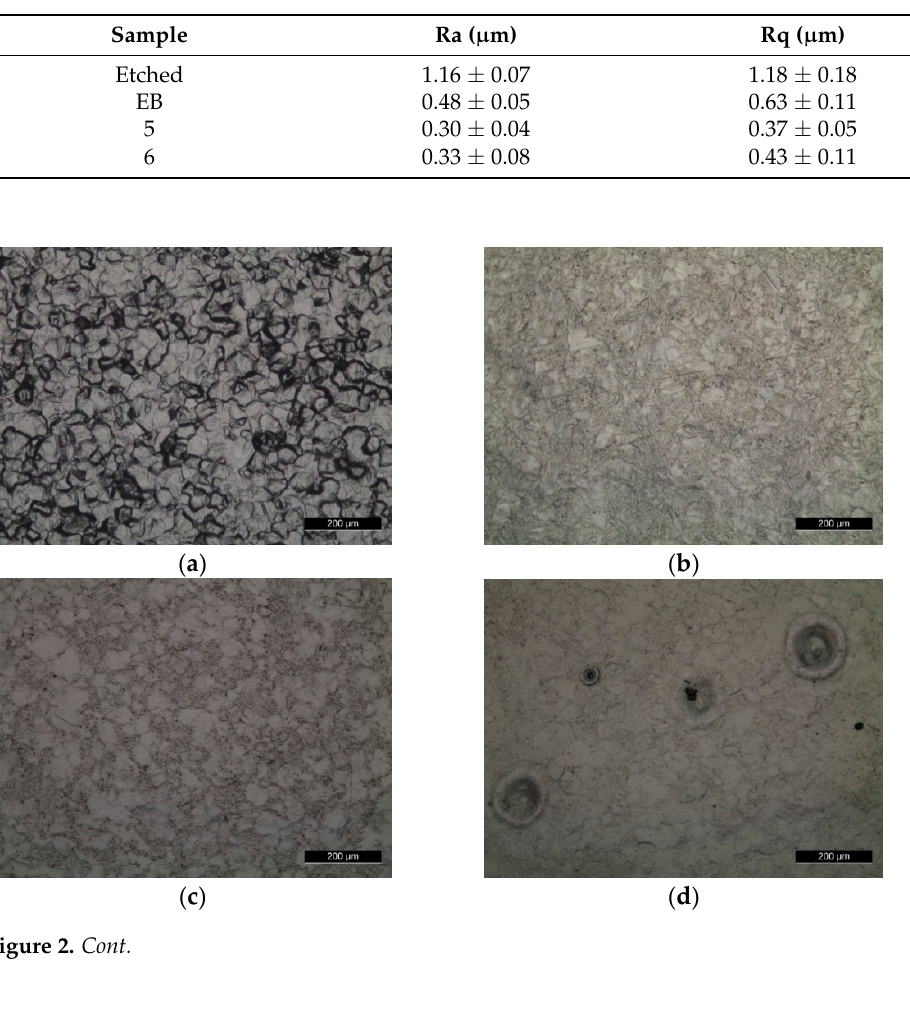
Table 4. Ra and Rq values for untreated and treated samples.